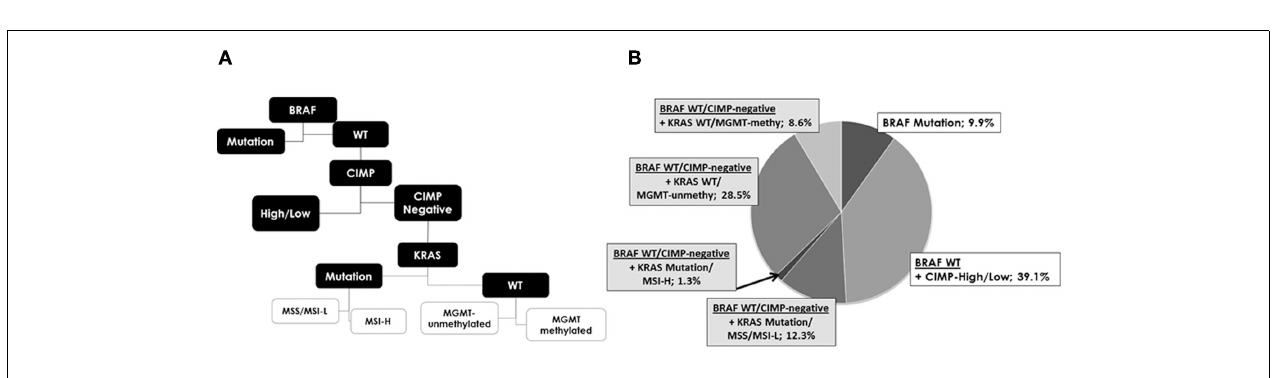
subgroup 2: CIMP-high, and CIMP-low and subgroup 3: CIMP-negative. KRAS , MGMT, and MSI contribute only little additional prognostic information. (B) Frequencies of each new